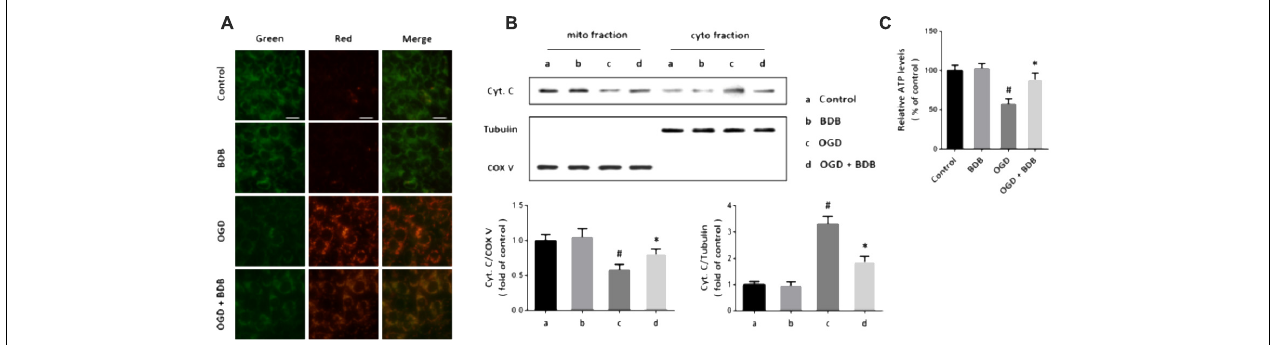
FIGURE 3 | BDB preserves mitochondrial function after ischemia. (A) Mito-Timer reporter gene assay shows that BDB reduced mitochondrial oxidative stress induced by OGD. (B) Western blot shows that BDB attenuated cytochrome c release from mitochondria induced by OGD. (C) ATP synthesis assay shows that BDB preserved mitochondrial ATP generation after OGD. Scale bar, 20 µ m. Data are shown as mean ± SEM ( n = 6). # p < 0.05 vs. Control. ∗ p < 0.05 vs.